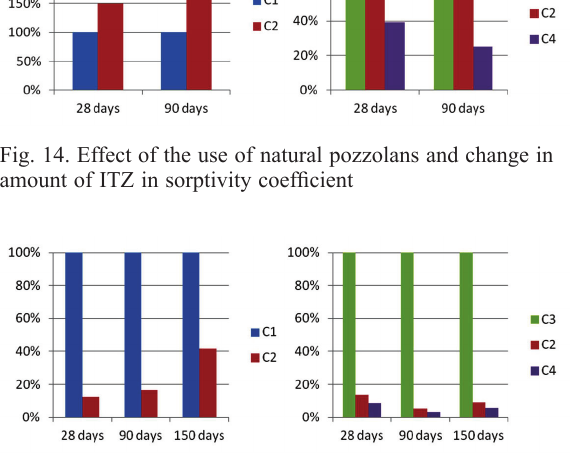
Fig. 15. Effect of the use of natural pozzolans and change in amount of ITZ in air